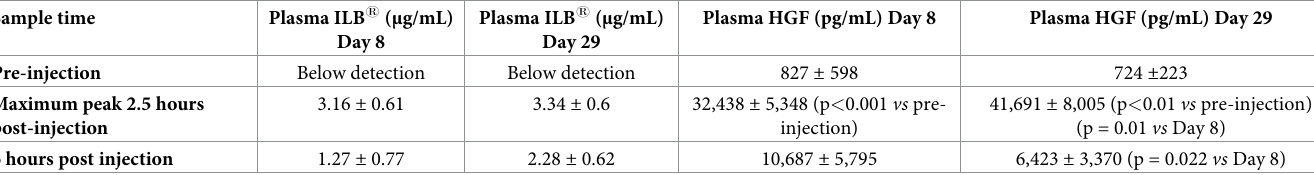
Table 5. Plasma ILB 1 and Hepatocyte Growth Factor (HGF) levels at Day 8 and Day 29 injections (N = 13; Mean ± SD). Sample